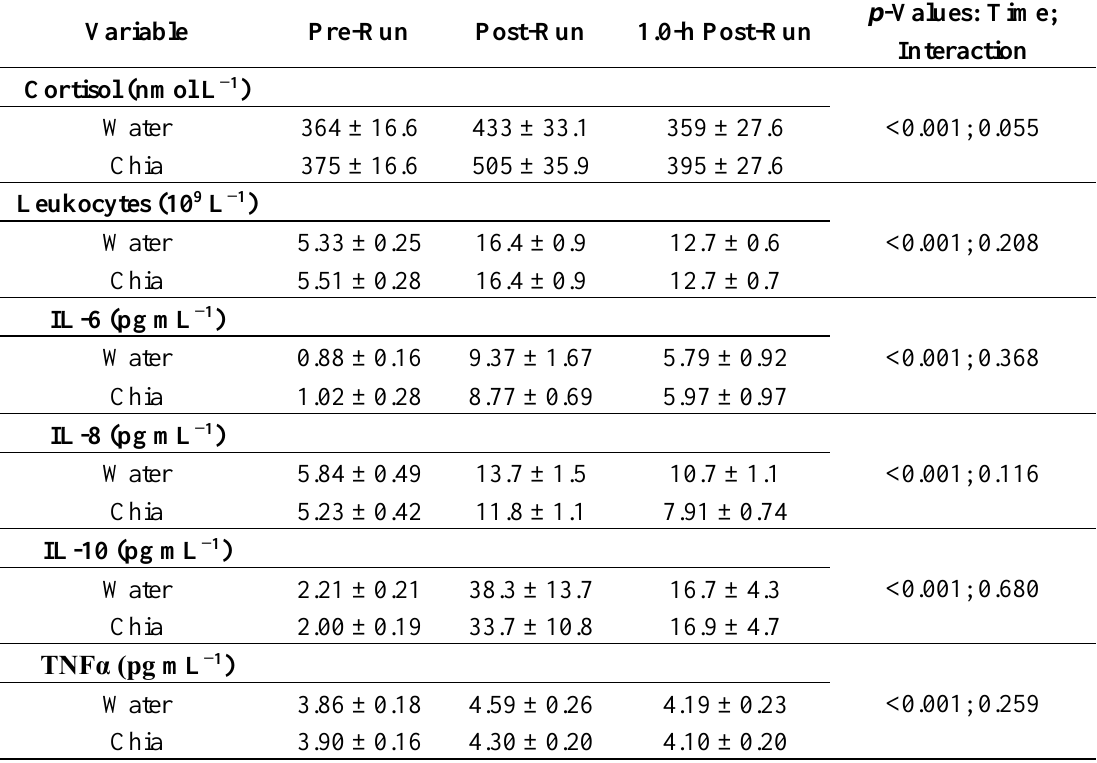
Table 3. Comparison between water and chia seed oil run-to-exhaustion trials for cortisol and inflammation biomarkers in trained runners ( n = 24) (mean ± SE). Variable